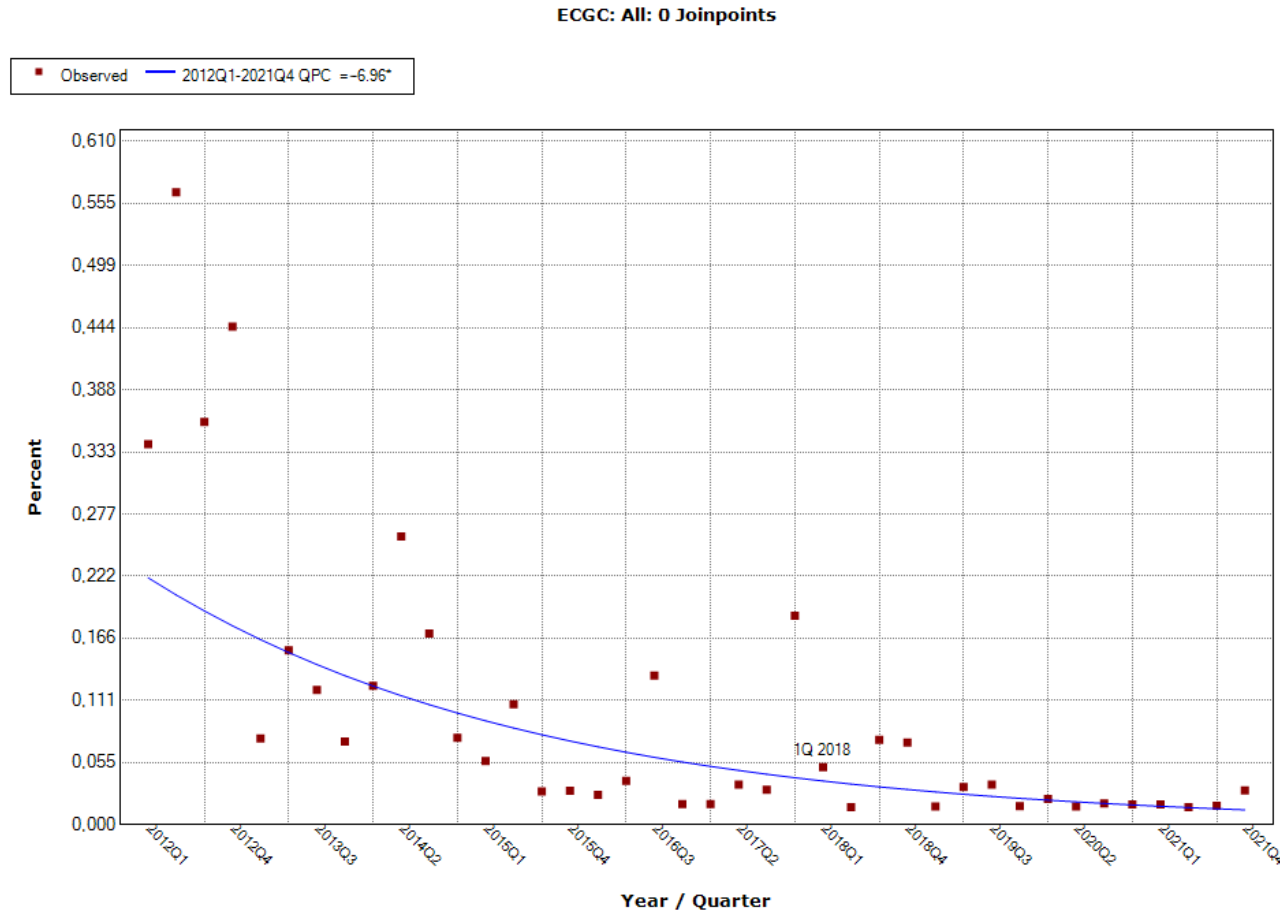
Figure A10. Percentage of products containing ECGC in individual quarters in the period from 2012 to 28 November 2021. Joinpoints mark trend turning points. The date above the observation indicates the moment of publication of the scientific opinion/resolution.